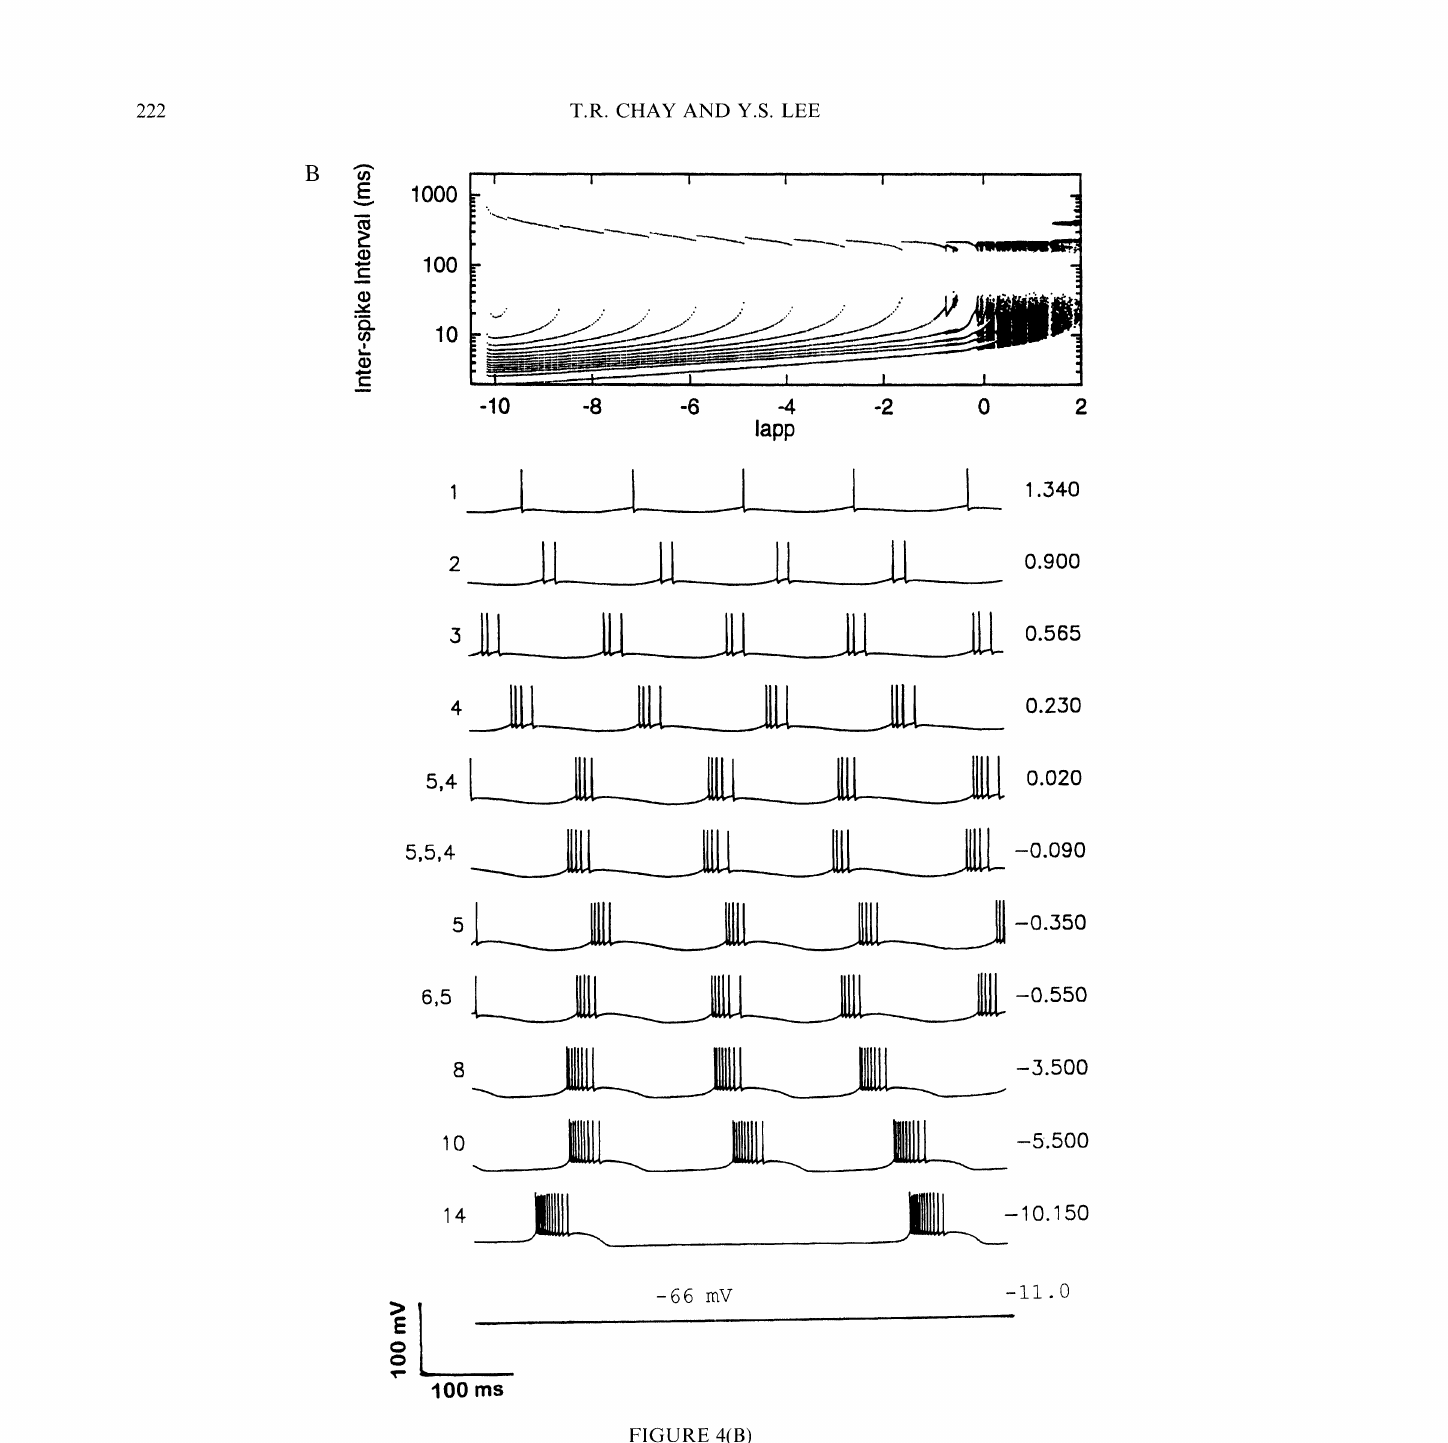
FIGURE 4 Time series generated by the thalamocortical neurons as a hyperpolarization current lap is increased fFOll’l the top to the bottom. A: Low- and high-amplitude oscillations and chaos are generated as lap decreased from the top to the bottom. The values shown on the right are the strength of lap in },tA/cm 2. B: Bursting exhibited by this neuron as I,pp is decreased further. The labels on the left represent the number of spikes per burst. For example, (5,4) represents bursting consisting of an alternating sequence of 4- and 5-spikes, and (5,5,6) represents the bursts consisting of an alternating sequence of 5-, 5-, and 6- spikes. The top frames of A and B show the interspike intervals (ms) fi’oln Fig. 7 in an expanded